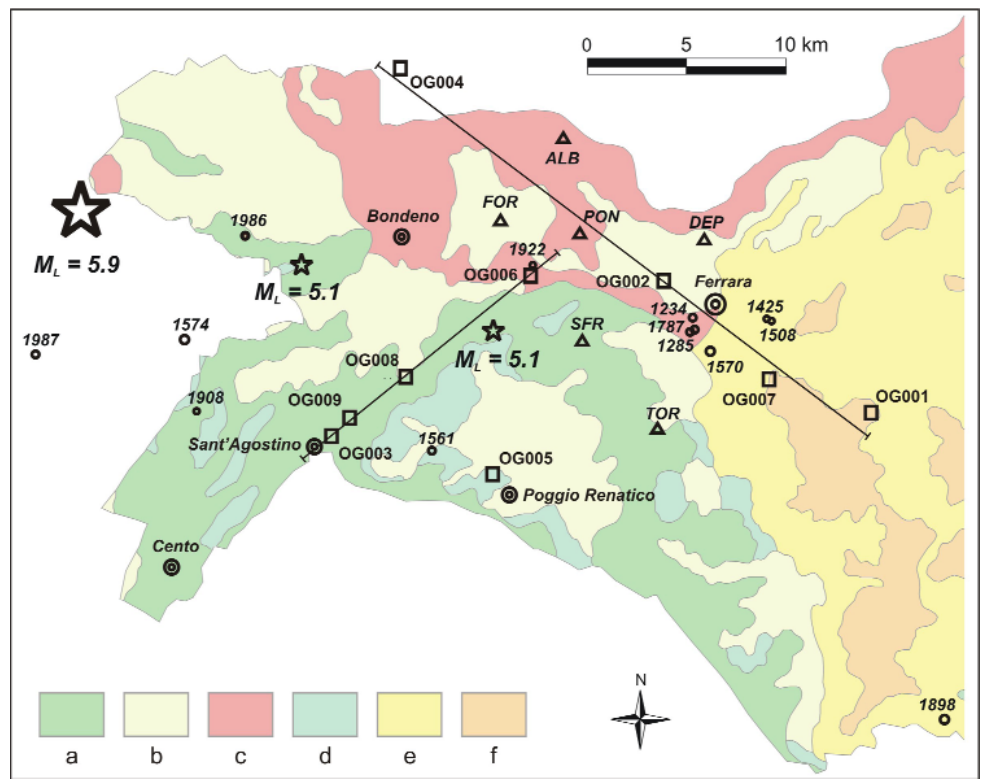
Figure 3. Simplified geological map of the western portion of the Ferrara Province showing the locations of the OGS temporary stations (squares), the permanent stations (triangles) of the local microseismic network of the Ferrara Municipality that is managed by Ferrara University (http://servizi. comune.fe.it/index.phtml?id=2593). Stars, principal shocks of May 20, 2012. Legend of stratigraphic units: (a) medium to fine sand (channel and proxi- mal levee deposits); (b) silty clay, clay and clayey silt (interfluvial and swamp deposits); (c) sandy silt, fine sand and silty clay (distal levee deposits); (d) medium-to-coarse-grained sand (alluvial plain and meander deposits); (e) medium to fine sand (distribution channels and levee deposits); and (f) silt, clayey silt (swamp deposits). The age of the outcropping sediments is Holocene everywhere. Modified after Banca Dati Regione Emilia-Romagna